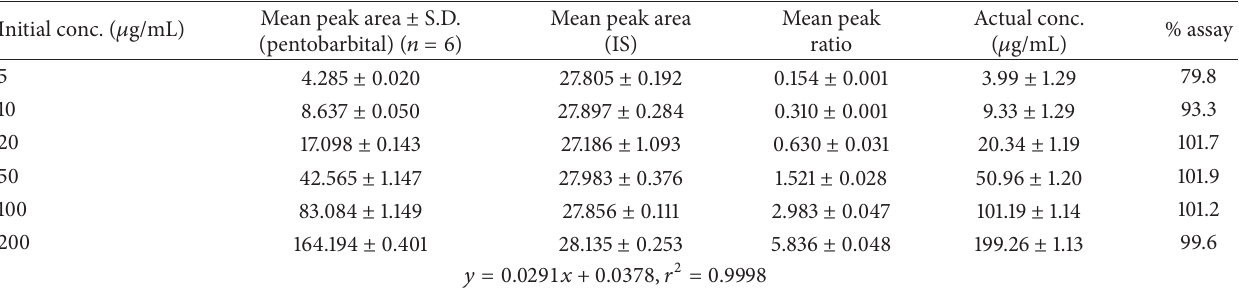
Table 3: Linearity data of the developed method.